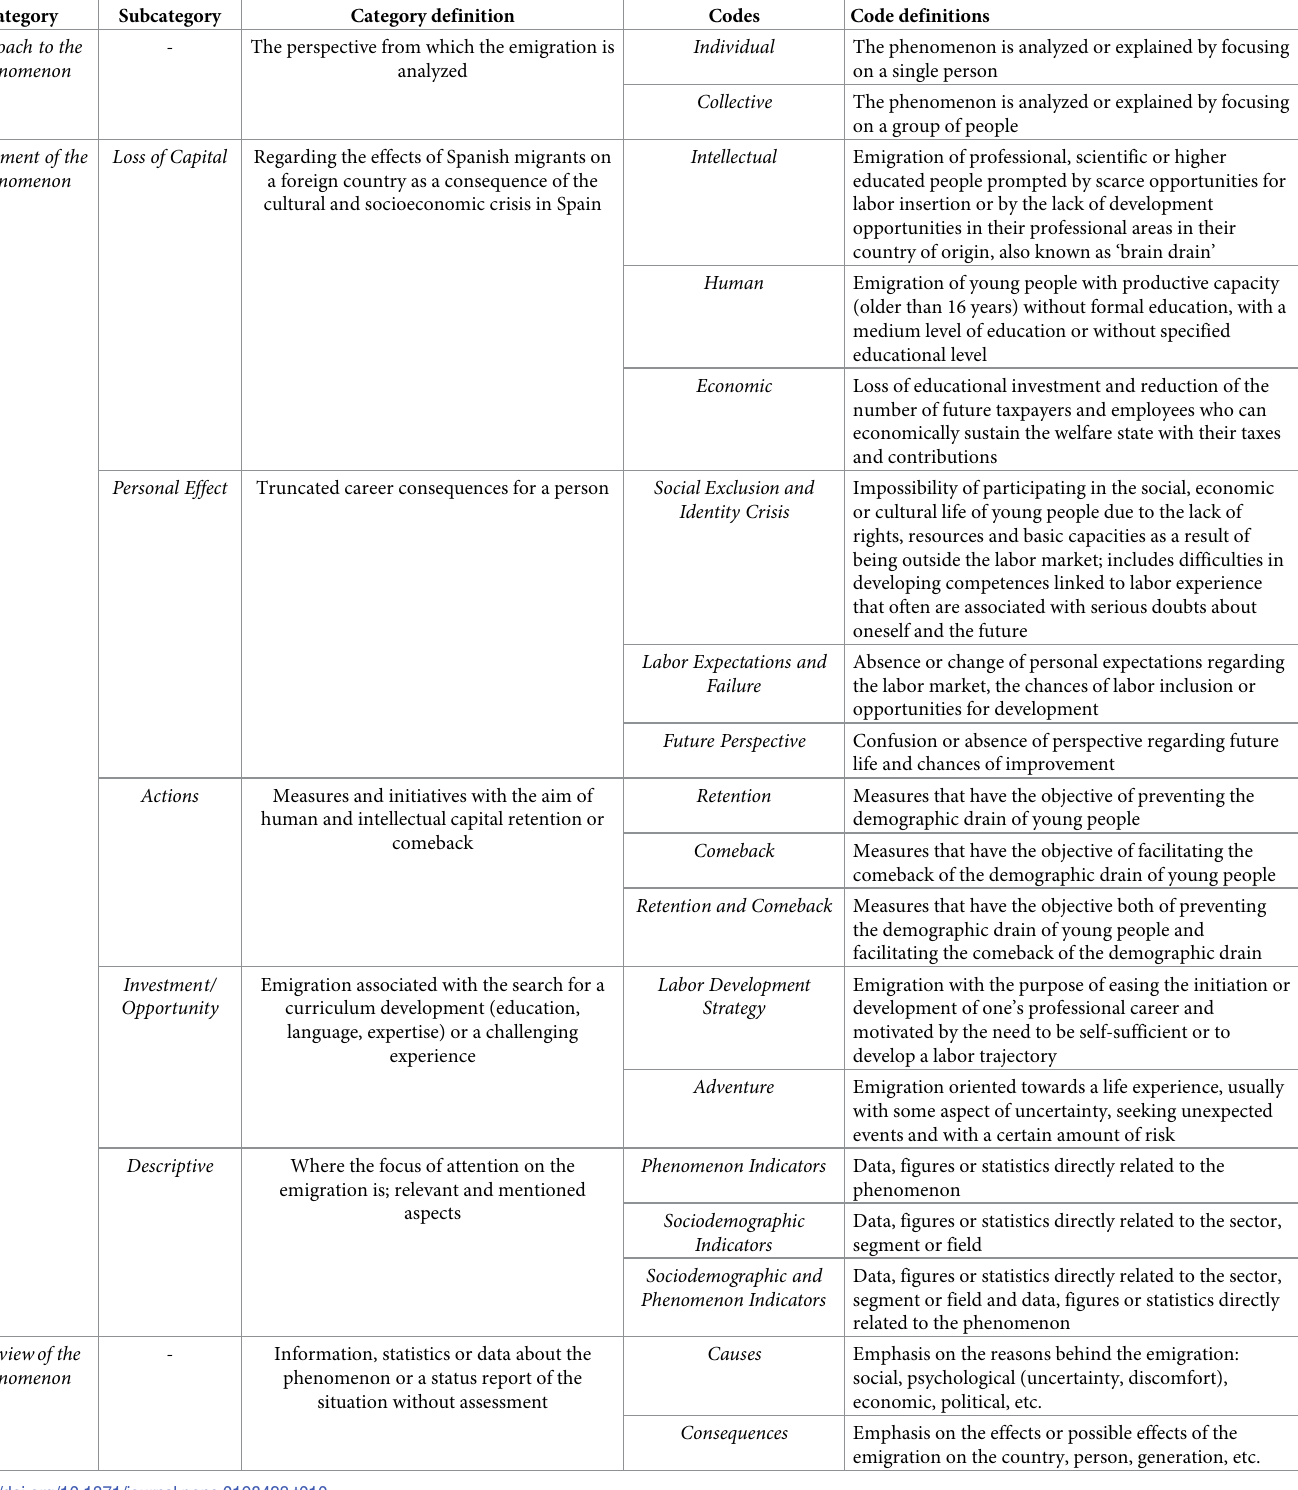
Table 10. Categorical